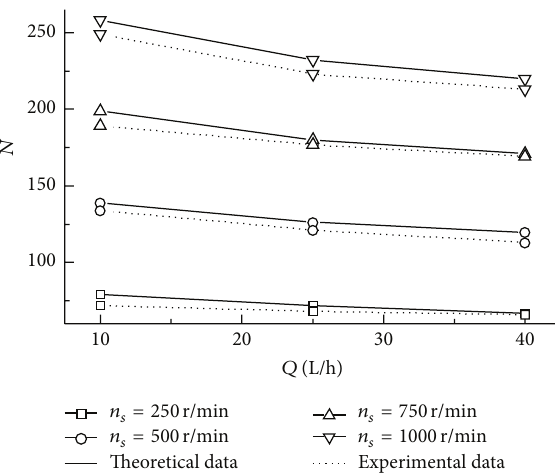
Figure 19: Comparison of theoretical and experimental